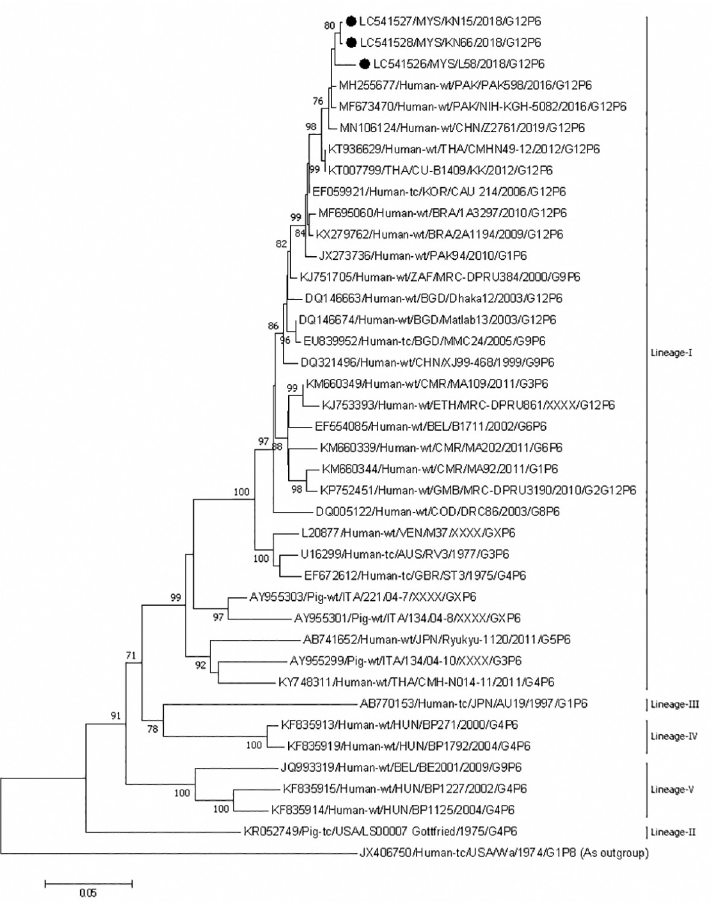
Fig 8. Phylogenetic tree constructed with the nucleotide sequences of the VP4 gene of P[6] strains. Human rotavirus Wa (P[8]) was used as an outgroup. The number adjacent to the node represents the bootstrap value and values lower than 70% have not been indicated. Scale bar shows genetic distance expressed as nucleotide substitutions per site. The strains identified in this study are marked with a filled circle. All strains from Sabah belong to lineage I. The nucleotide sequences of our strains have been submitted to the databases of the DNA DataBank of Japan, the European Molecular Biology Laboratory, and GenBank. The accession numbers are shown at the beginning of each